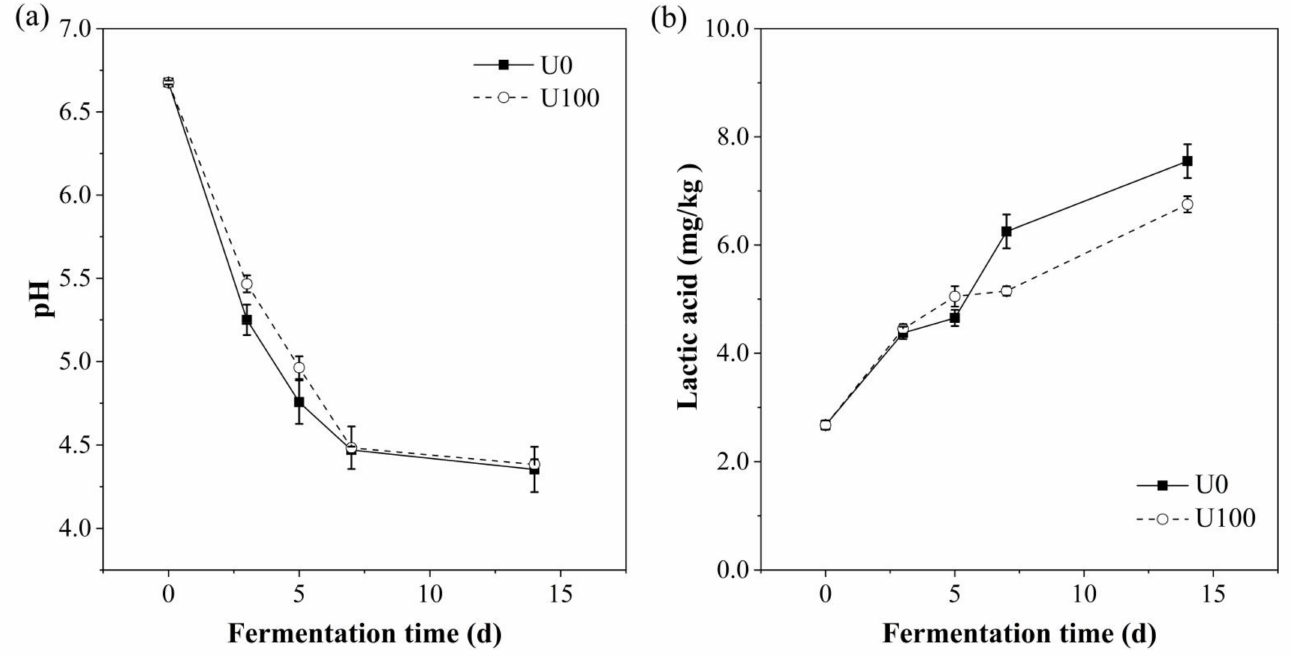
Figure 1. Changes of pH ( a ) and lactic acid content ( b ) in the samples during the fermentation of Suanzhayu without (U0) and with (U100) lipase. Samples were collected at 0, 3, 5, 7, and 14 d,